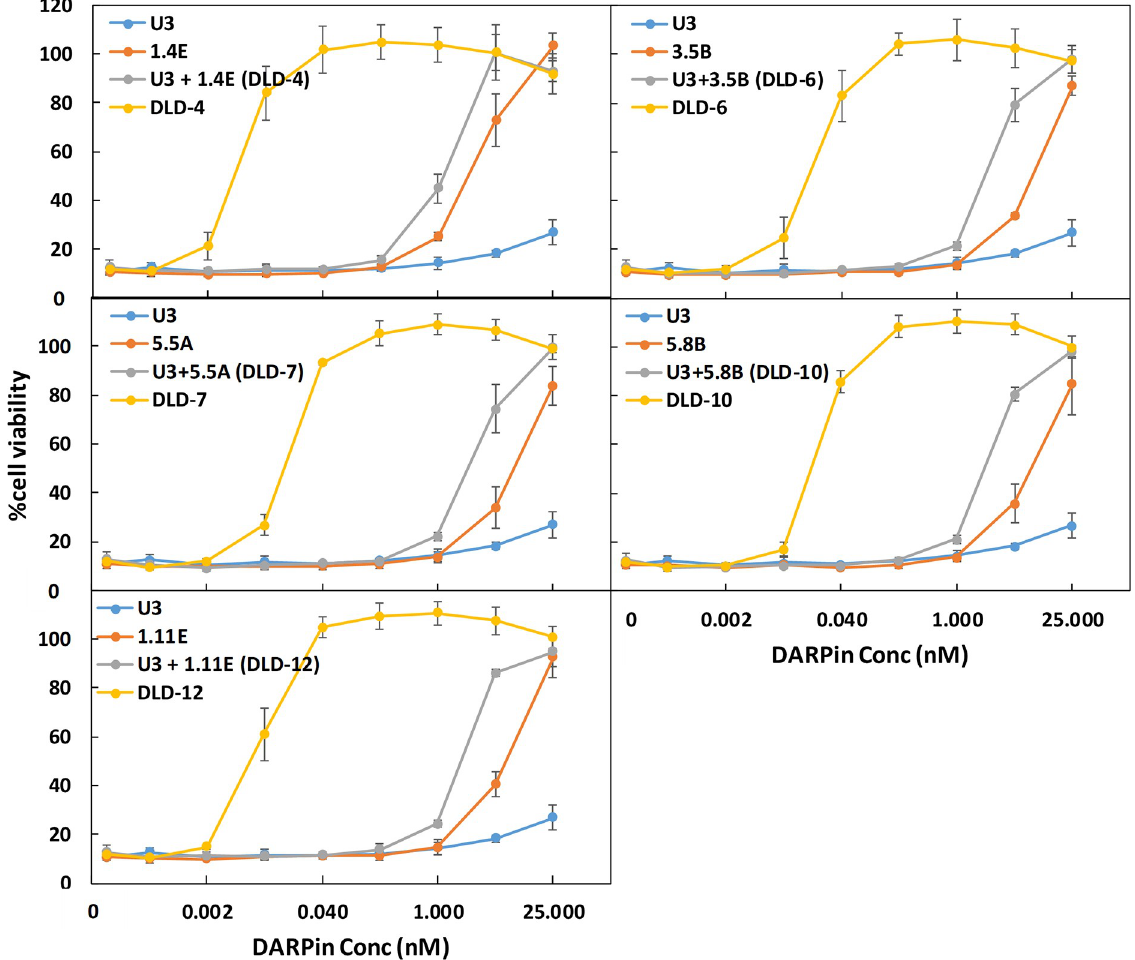
Fig 3. DARPin dimers exhibit superior toxin-neutralization potency relative to the constituent monomers. IMAC-purified DARPin dimers or monomers were added to Vero cells (1.5 × 10 3 cells/well) together with TcdB (5 pg/mL). Cell viability was quantified 72 hours later by CellTiterGlo assay and normalized to na ï ve Vero cells. Error bars represent the standard deviation of at least 2 independent experiments performed in duplicate. Conc, concentration; DARPin, designed ankyrin repeat protein; IMAC, Immobilized metal affinity chromatography; TcdB, C . difficile toxin